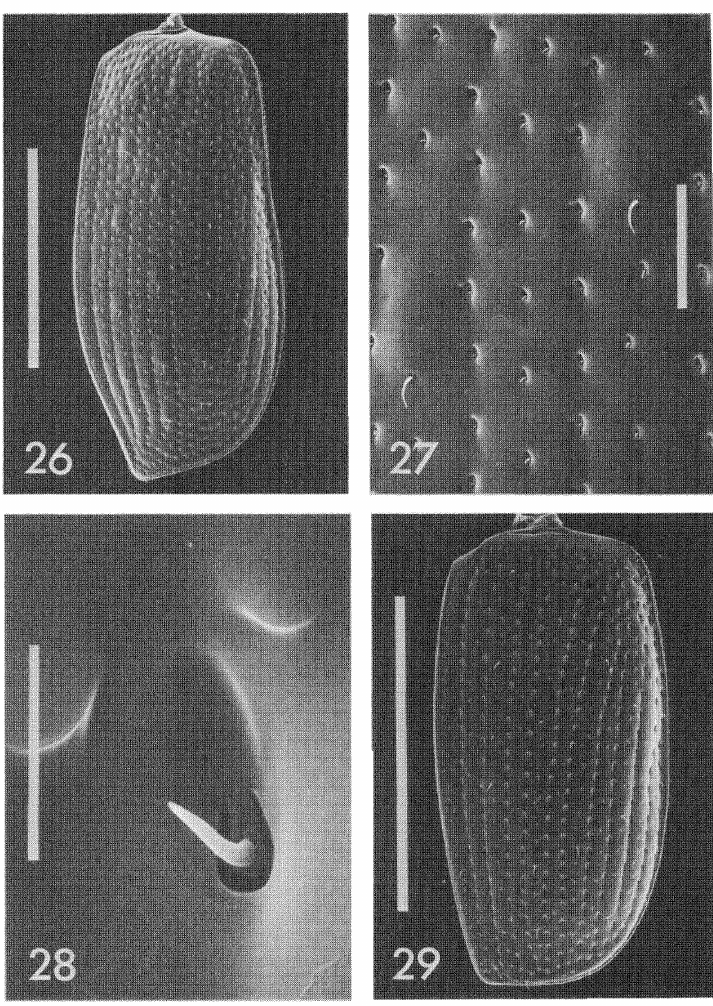
Figs. 26-29. Glypholoma spp. 26-28. G. pustuliferum, right elytron; 26, dorso- lateral view; 27, detail of fig. 26, including two pustules; 28, strial puncture (detail of fig. 26). 29. G. rotundulum, right elytron, dorsolateral view. Scale lines: figs. 26, 29 1.0 mm; fig. 27 0.1 mm; fig. 28 0.01